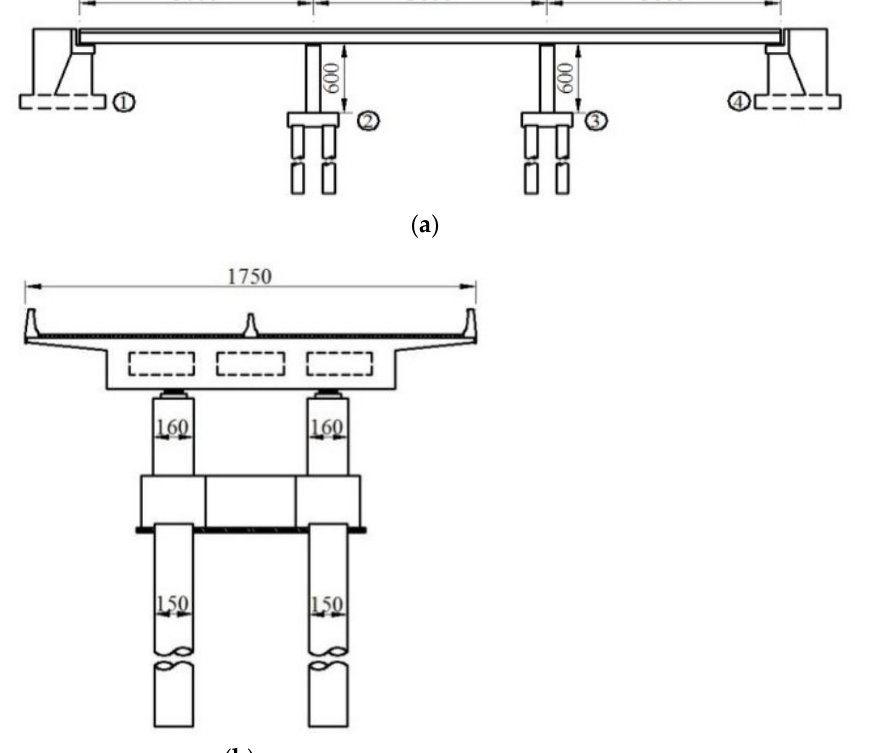
Table 1. Basic parameters of the bridge structure.